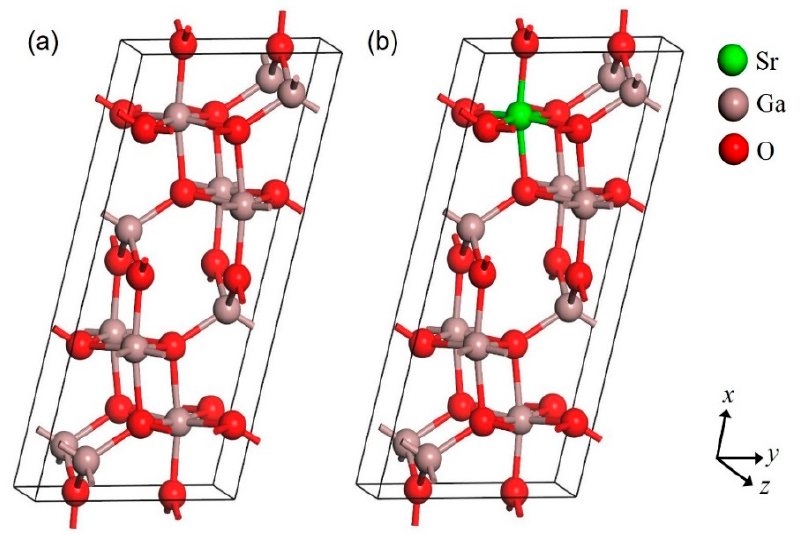
Figure 1. Crystal structure of 1 × 1 × 1 unit cell of ( a ) pure β -Ga 2 O 3 and ( b ) Sr-doped β -Ga 2 O 3.